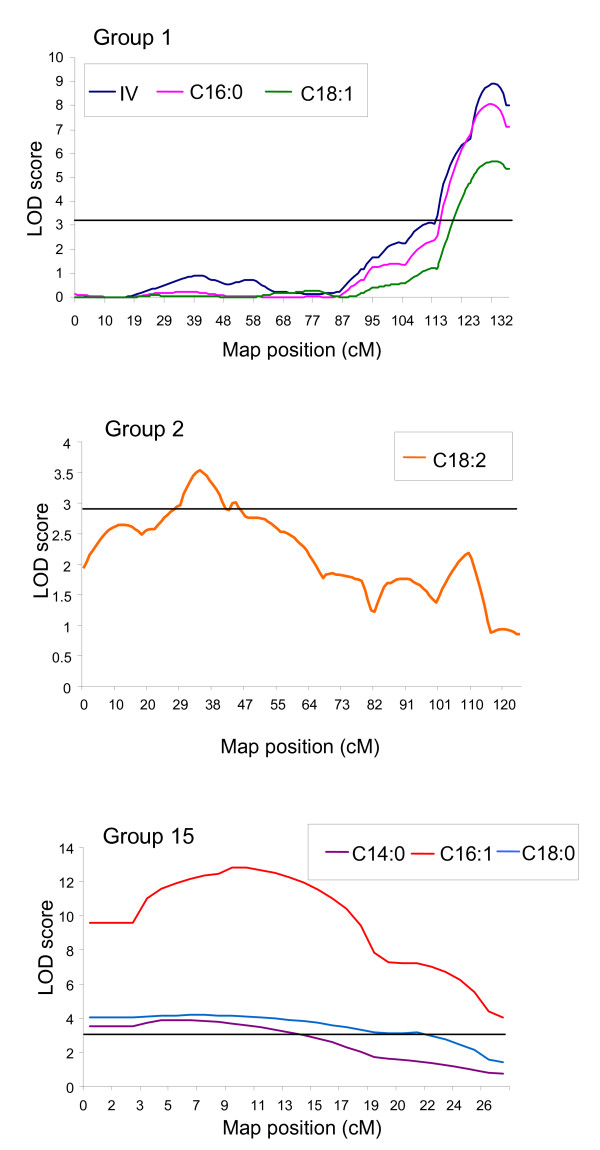
QTL graphs for IV and the various fatty acid compositions on Groups 1, 2 and 15. Results from the Interval Mapping approach. Horizontal line indicates the 95% significant threshold value for declaring a QTL.